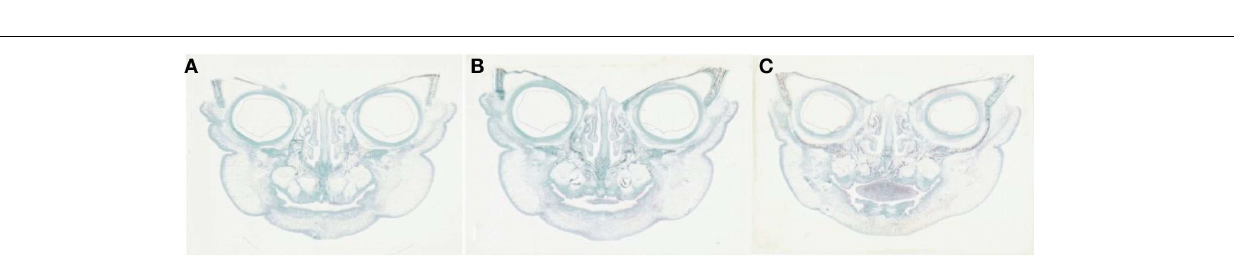
FIGURE 2 | (A–C) Representative serial histological sections (frontal plane) from the Pena–Shokeir fetus tracing the progressive merging of the lateral parts of the lip and mandible to the central one (sections from left to right